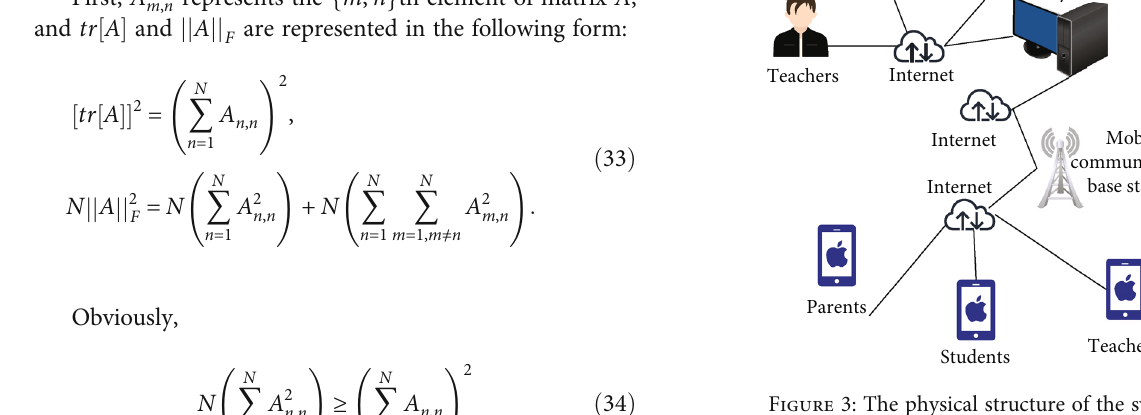
Figure 3: The physical structure of the